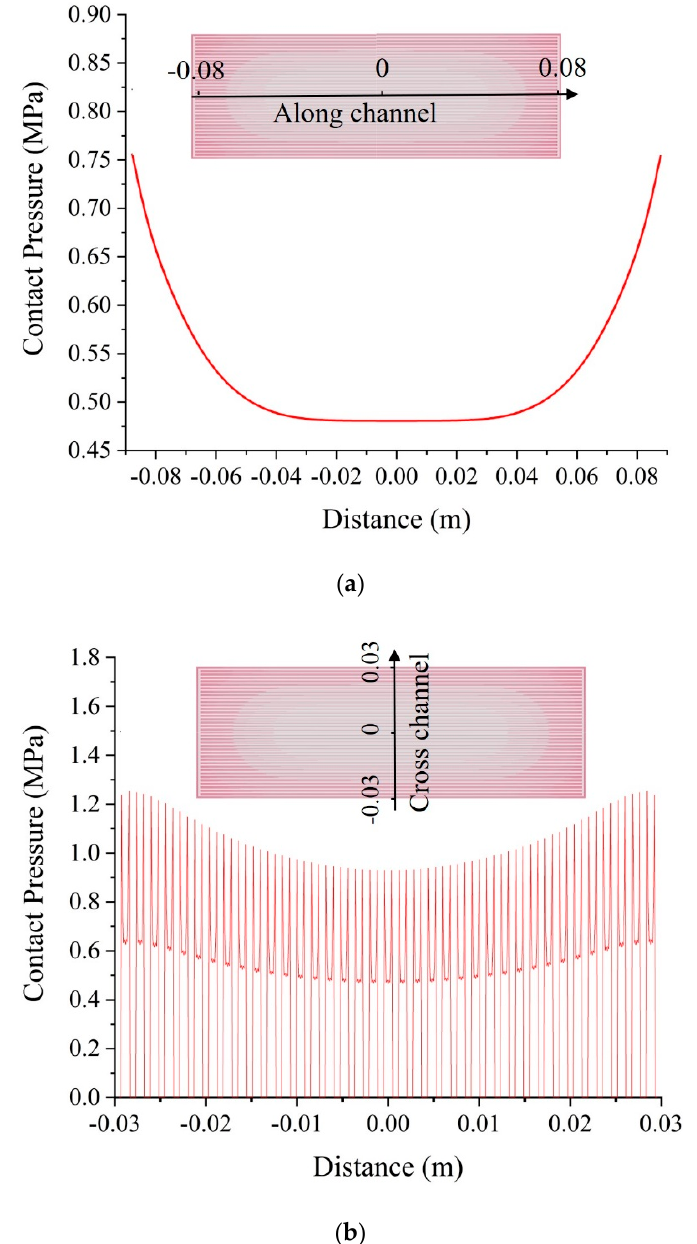
Figure 8. Contact pressure distributions ( a ) along the channel and ( b ) across the channel.